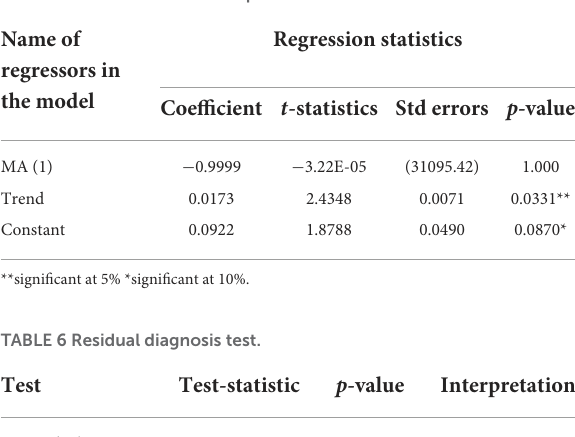
TABLE 5 Model estimation output.